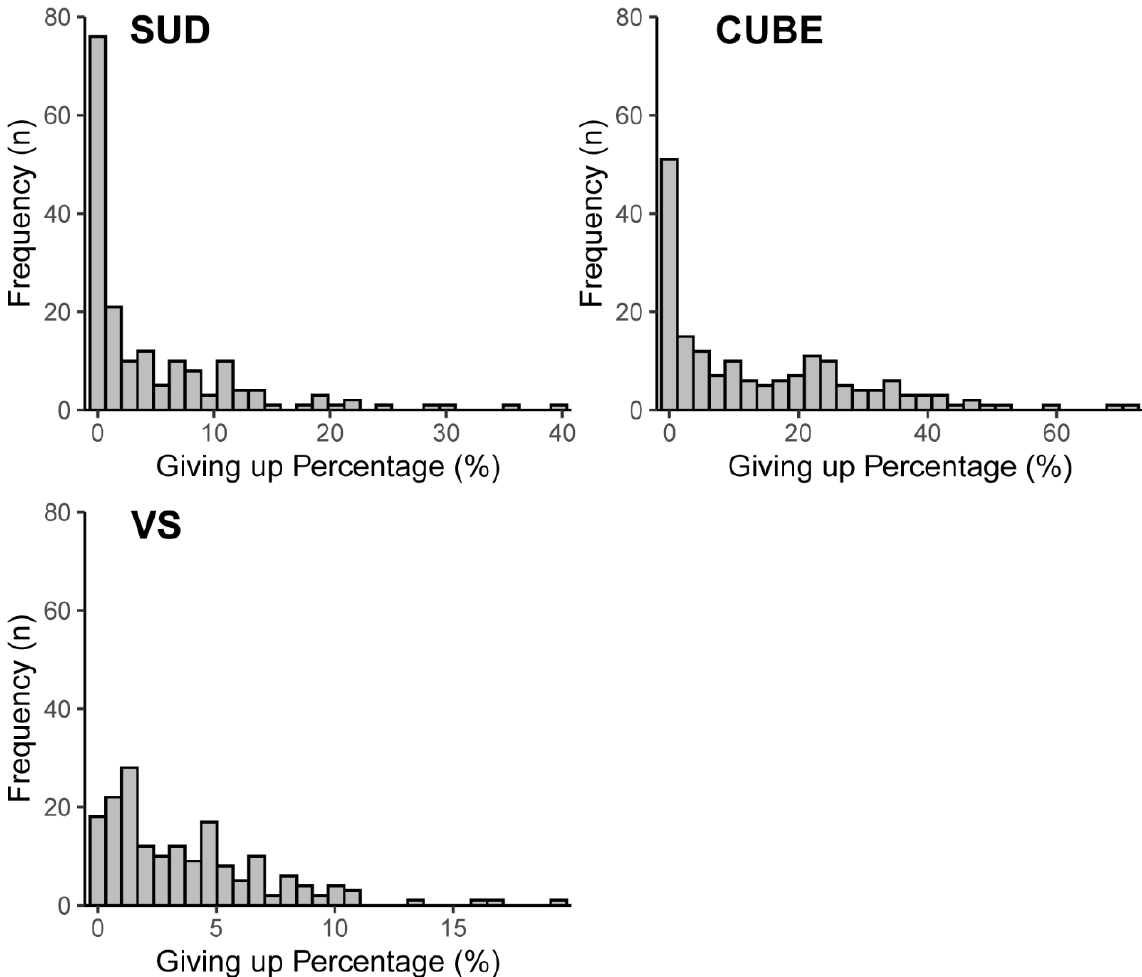
Figure 2. Frequency histograms for the giving up scores in the SUD, CUBE, and Visual Search tasks.